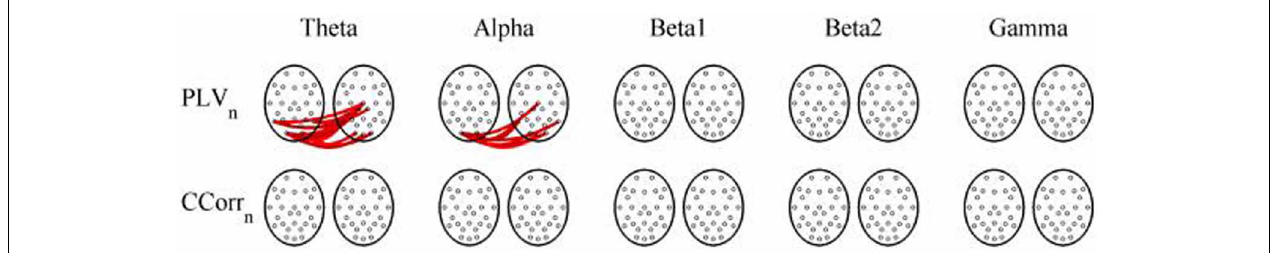
FIGURE 10 | Significant changes in mean trial-averaged hyperconnectivity between pre- and post-stimulus conditions by connectivity measure and frequency band. The rows represent the hyperconnectivity results for each of the measures used (PLV n and CCorr n ) and the columns represent the frequency bands (theta, alpha, beta1, beta2, and gamma). The pairs of large circles in each cell represent the heads of the participants in a pseudo-pair. The smaller